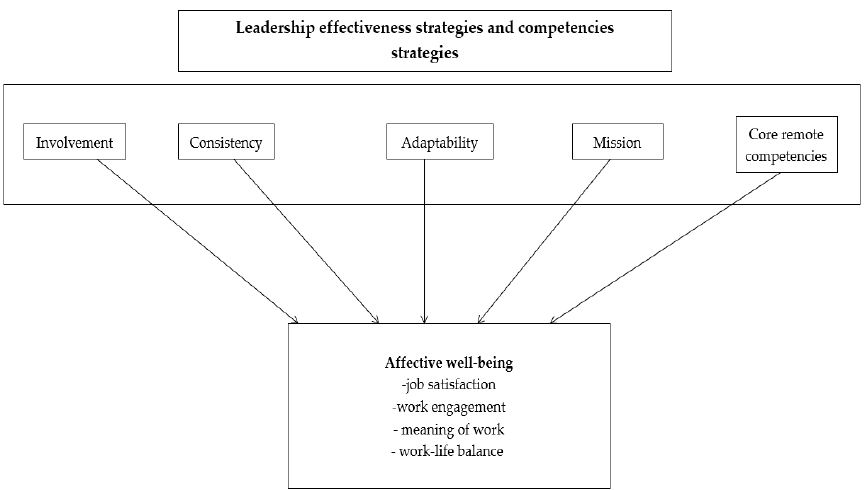
Figure 1. Variables used in the study.